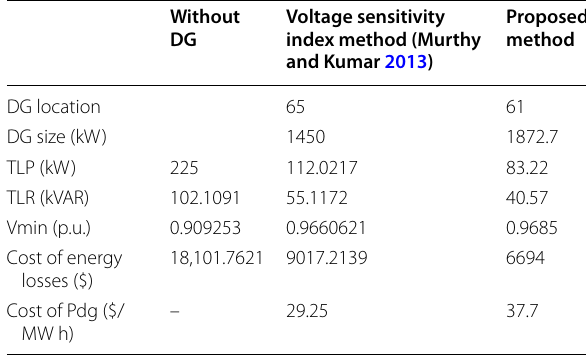
Table 7 Results for 69 bus system with DG at upf